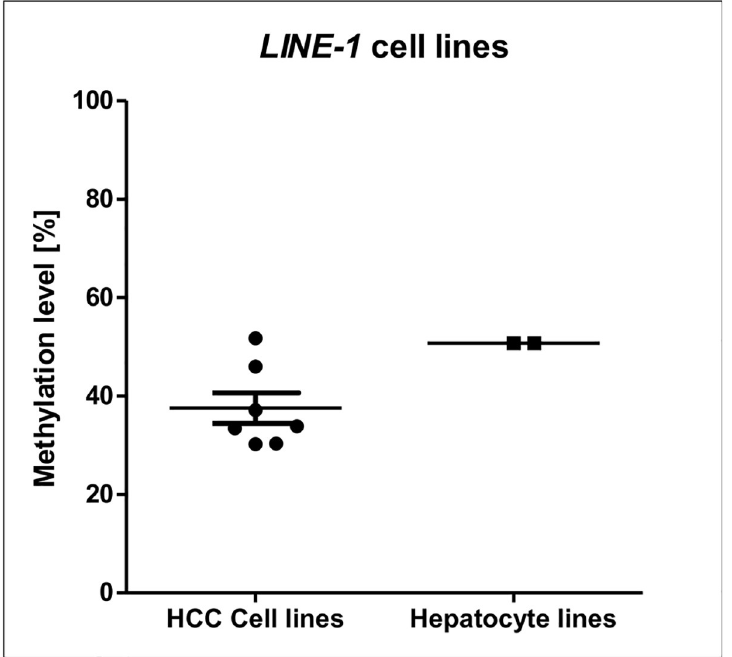
Fig 1. LINE-1 DNA methylation levels in HCC cell lines and hepatocyte cell lines. Seven HCC lines showed significant lower DNA methylation levels than hepatocytes lines (mean methylation37.52 ± 3.12 vs. 50.73 ± 0.02 respectively, p = 0.005). For DNA methylation levels of individual CpG sites see S2